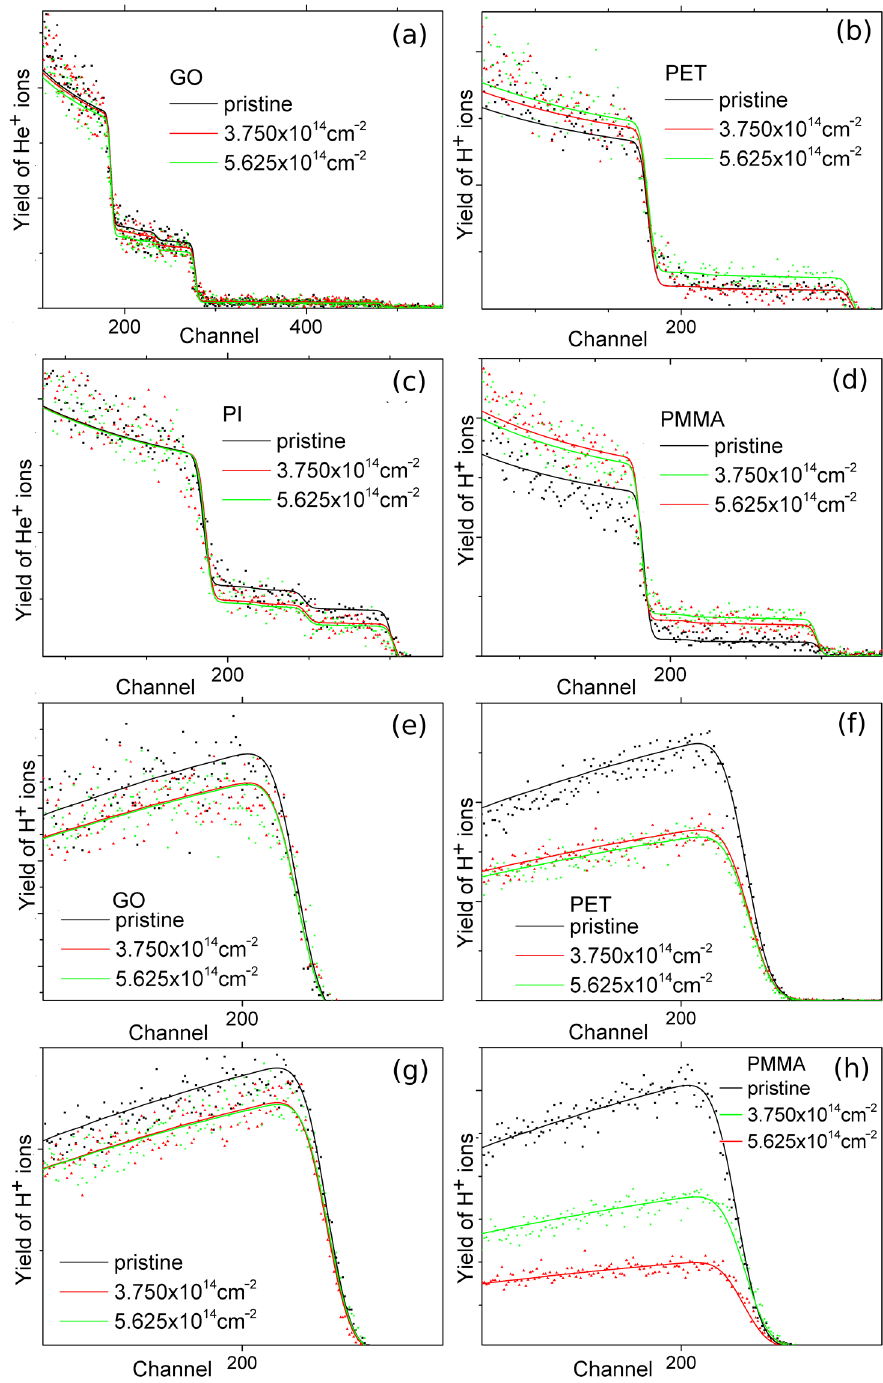
Figure 3. The RBS experimental spectra (points) and SIMNRA simulated spectrum (line) for GO ( a ), PET ( b ), PI ( c ), and PMMA ( d ) and the experimental ERDA (points) and SIMNRA simulated (line) spectra for GO ( e ), PET ( f ), PI ( g ), and PMMA ( h ), all pristine and irradiated by 5.0 MeV carbon ions with fluences of 3.75 × 10 14 cm − 2 and 5.625 × 10 14 cm − 2 .